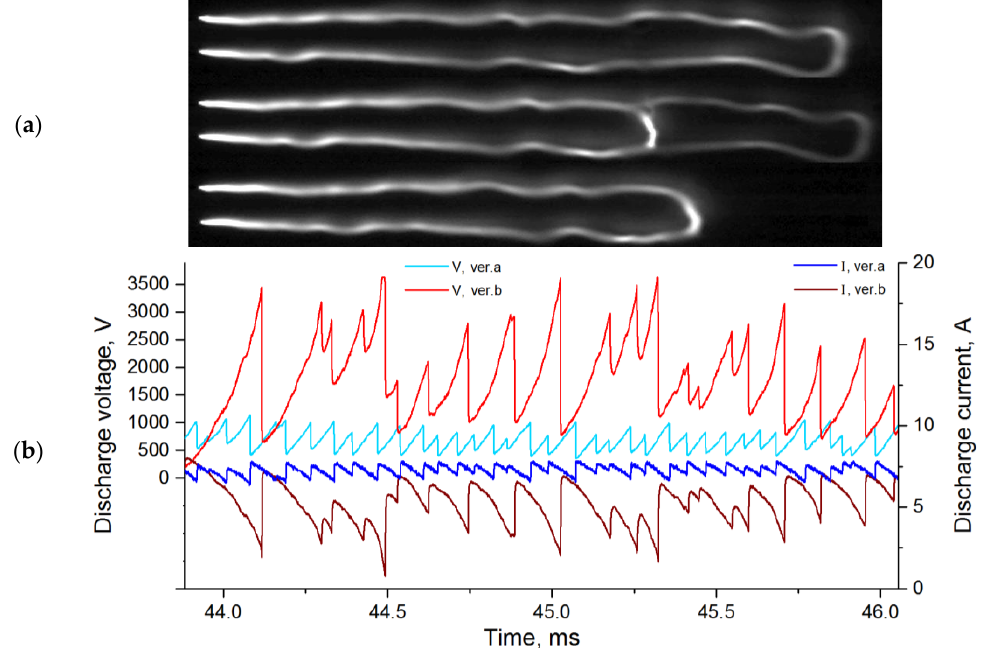
Figure 6. Re-breakdown process visualization (0, 5, and 15 µs) ( a ); Oscillograms of voltage and